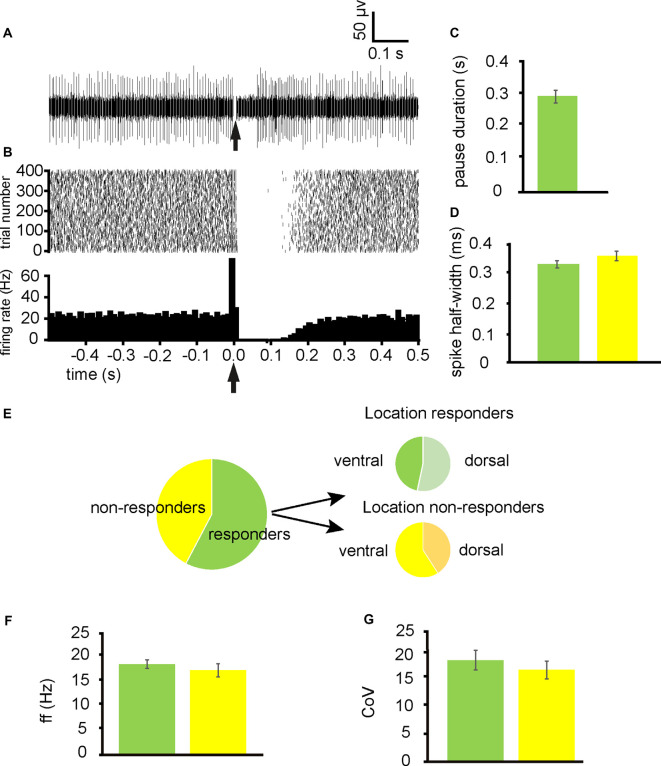
Stimulation ofthe nucleus accumbens (NAc) results in inhibition of tonic firing in some ventral pallidum (VP) neurons. All experiments represented in this figure used the second stimulation protocol (100 Hz) identified in the “Materials and Methods,” section. (A) A typical example of a raw data trace from a neuron in the VP with a pause (responder) in tonic activity after stimulation of the NAc. (B) A typical example raster plot (above) and peri-stimulus time histogram (PTSH, below, in bins of 10 ms) of tonic firing activity in a VP neuron 0.5 s pre-stimulation and 0.5 s post-stimulation of the NAc. The raster plot exemplifies one neuron response during 400 applications of stimulation. (C) Bar chart representing average pause duration for those neurons that were responders to NAc stimulation. (D) Bar chart representing the non-significant difference in spike half-width (ms) for neurons that responded to NAc stimulation (green) and those that were non-responders (yellow). (E) Pie charts representing the proportion of neurons identified in the VP for analysis that responded to NAc stimulation, and the proportions that were located ventrally vs. dorsally within the VP. (F) Bar chart representing non-significant differences in baseline firing frequency rates for neurons that responded to NAc stimulation (green) and those that were non-responders (yellow). (G) Bar chart representing the non-significant difference in baseline coefficient of variation for those neurons that responded to NAc stimulation (green) and those that were non-responders (yellow).